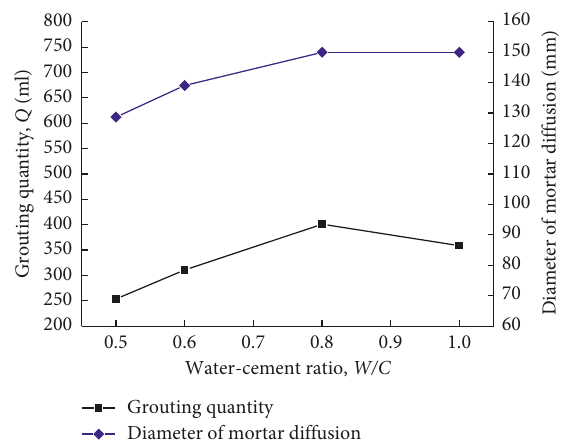
Figure 22: Characteristics of slurry diffusion ( P � 0.4 MPa, k 3 �